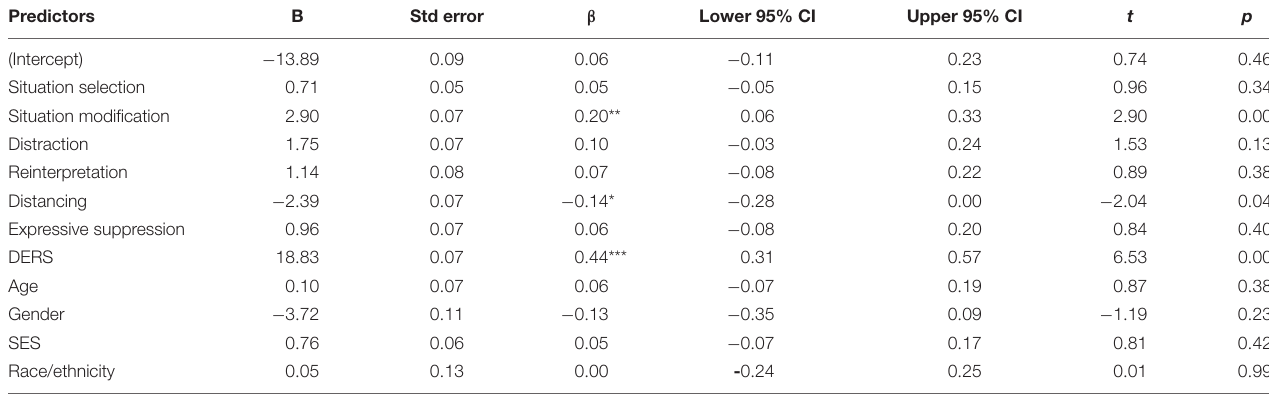
TABLE 2 | Robust multiple regression